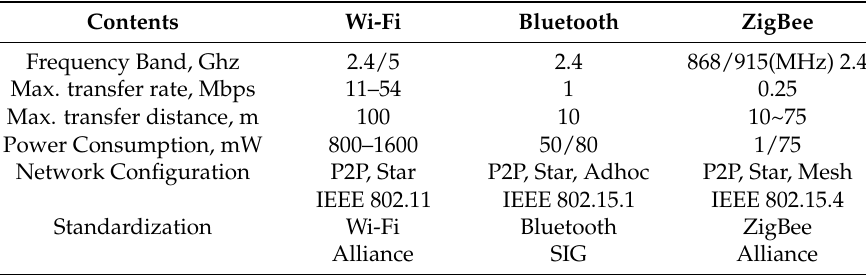
Table 1. Comparison of wireless network techniques.